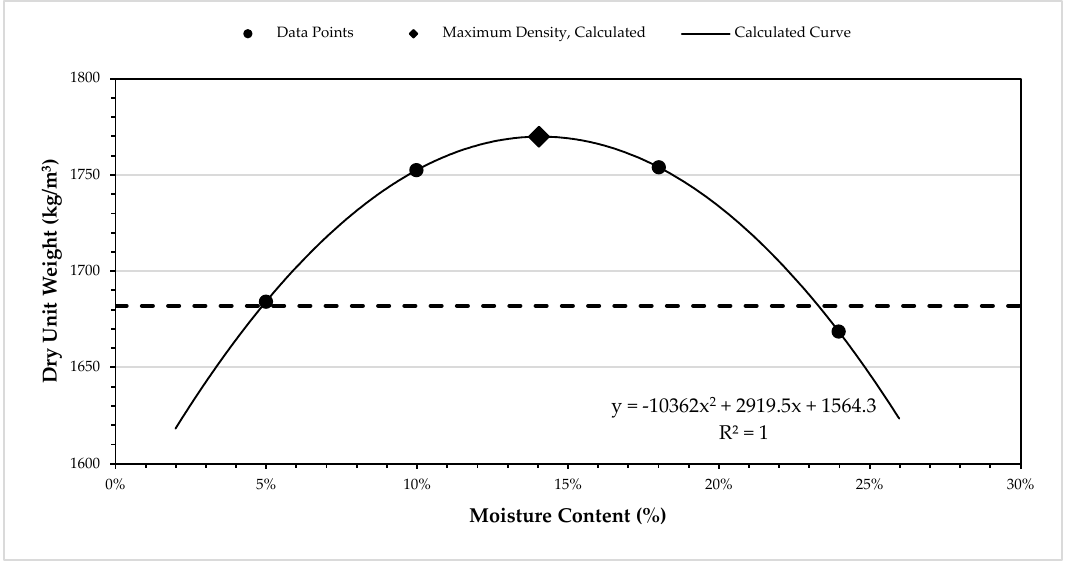
Figure 2. Proctor curve for experimental soil.